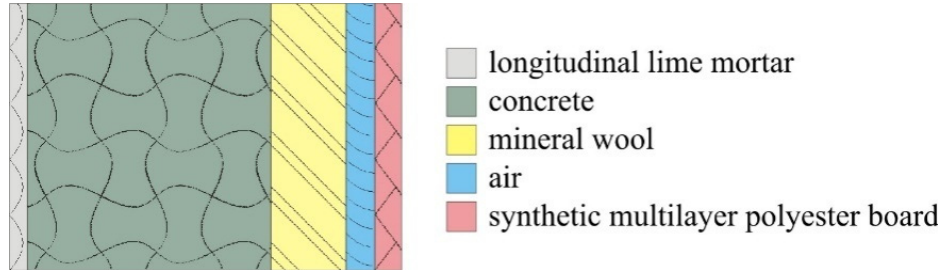
Figure 1. External wall of a ventilated façade.